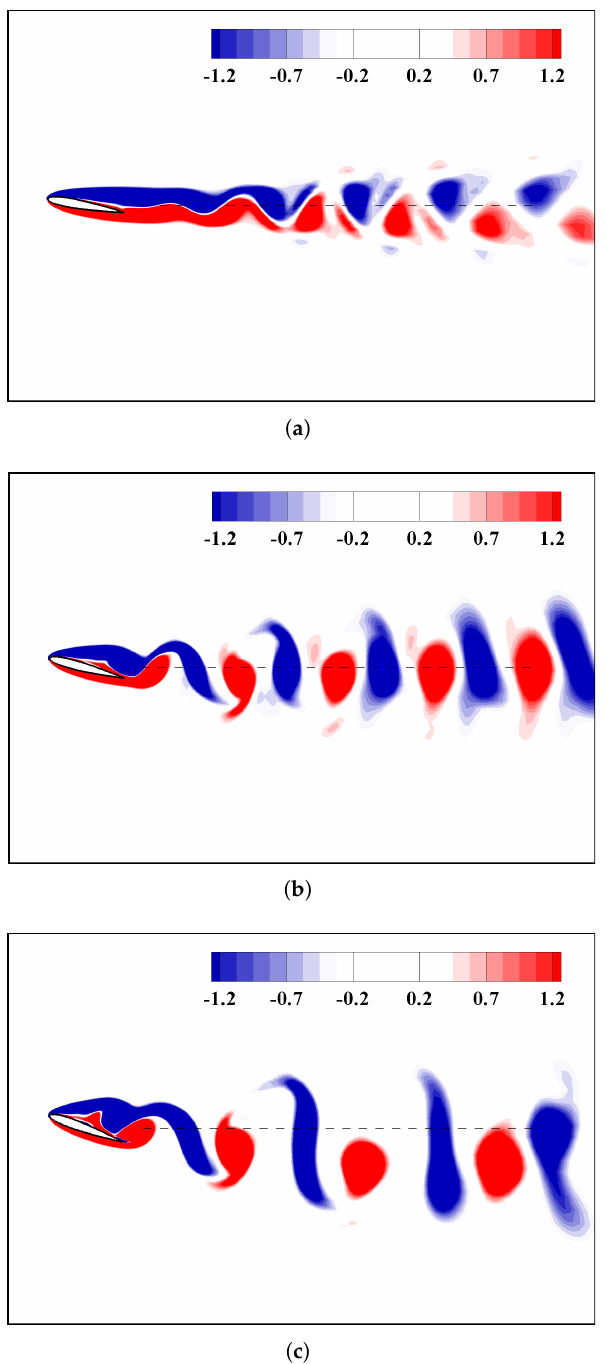
Figure 9. Snapshots of spanwise vorticity contours, ( a ) AOA = 10 ◦ , ( b ) AOA = 15 ◦ , and ( c ) AOA = 20 ◦ . Similar to the mean mode, we plot the distribution of first four pressure modes, ψ s , and i their decomposition into sine, − ψ s sin ( . ) and cosine, − ψ s cos ( . ) , components in Figure 12, i i since first four modes are enough to capture the physics of force on the airfoil surface. It can be seen that the pressure modes distribution near the vicinity of edges is dominant. The overall contribution of pressure modes into the lift and drag coefficients can be inferred by integrating the components − ψ s sin ( . ) and − ψ s cos ( . ) , respectively, over the airfoil i i